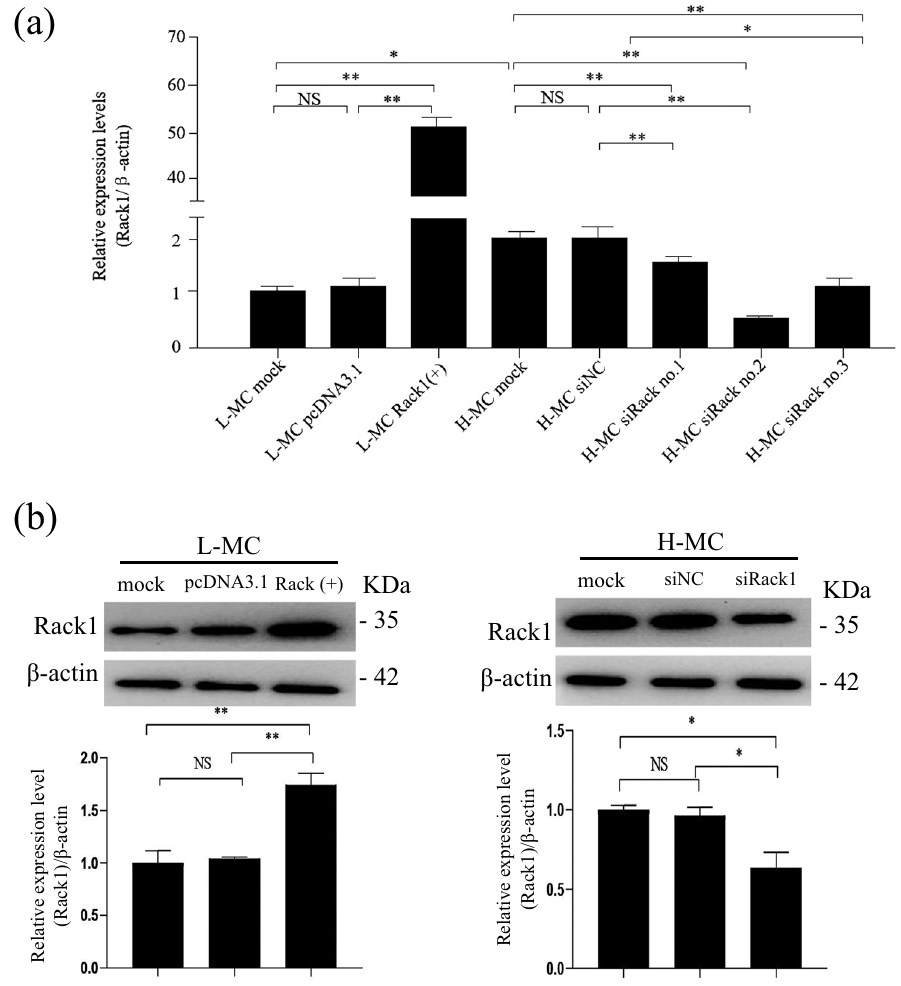
Figure 3: Construction of Rack1 overexpression plasmid and siRNA. Rack1 was overexpressed or silenced by Rack1 (+) plasmid or Rack1 siRNAs by ( a ) qRT - PCR and ( b ) western blot. The result showed that the expression of Rack1 was signi fi cantly increased in mesangial cells transfected with Rack1 overexpression plasmid Rack1 (+) in the L - MC group compared with that in cells transfected with empty plasmid pcDNA3.1 and untreated cells. Moreover, the result showed that the expression of Rack1 was decreased in mesangial cells transfected with Rack1 siRNAs ( No. 2 and No. 3 ) in the H - MC group compared with that in cells transfected with the siRNA control and untreated cells by qRT - PCR. Data showed the e ff ect of No. 2 was best. The data are representative of three independent experiments and presented as mean ± SD. ** p < 0.01; * p < 0.05; NS, no signi fi